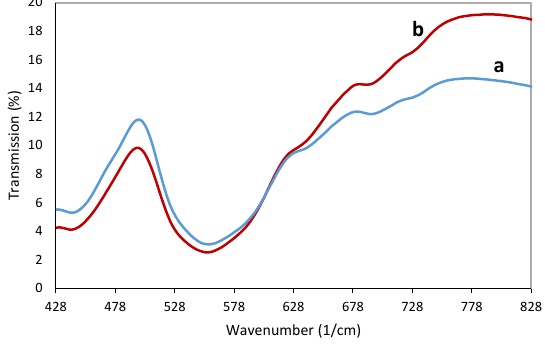
Fig. 2: FTIR spectrum of BFO particles a) before and b) after the reaction